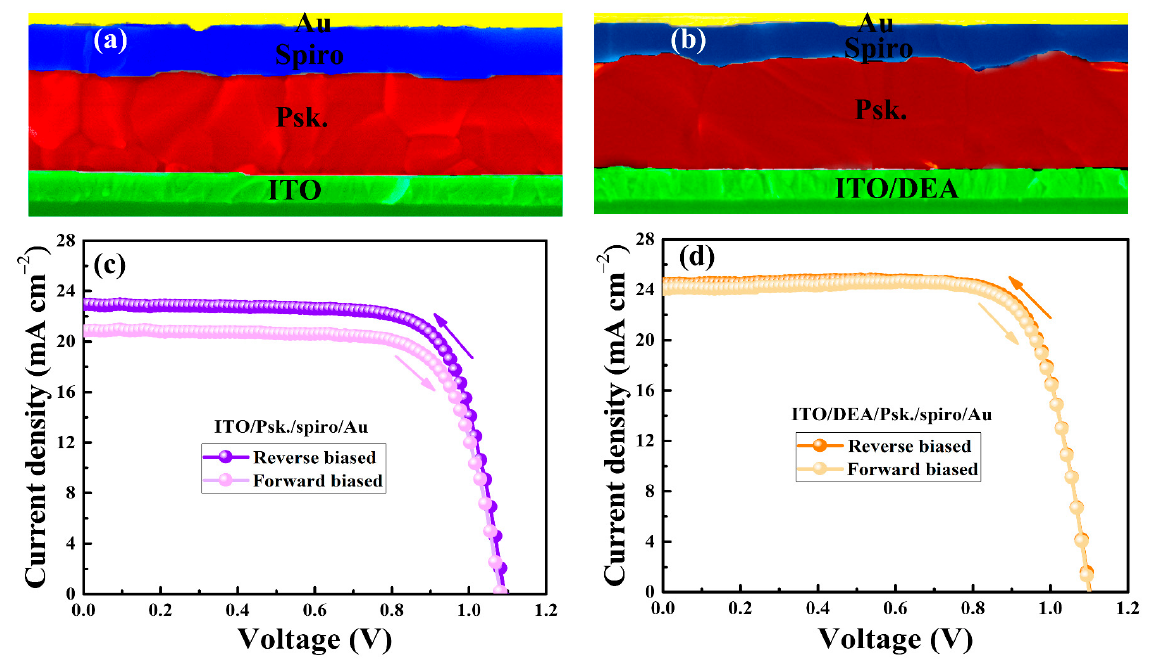
Figure 6. Cross-sectional SEM images of as-fabricated devices with ITO substrate ( a ) and ITO/DEA substrate ( b ). The J-V characteristic curves of devices fabricated with ITO substrate ( c ) and ITO/DEA substrate ( d ). Table 1. Photovoltaic parameters of the PSCs under forward bias and reverse bias.